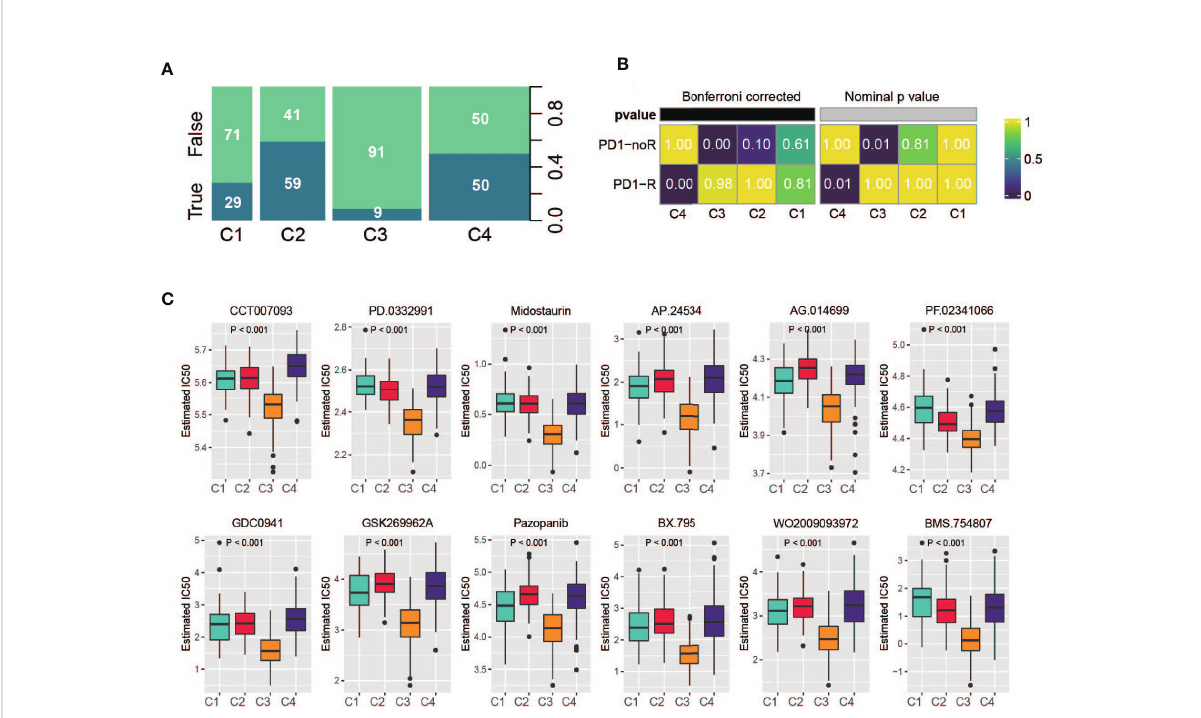
FIGURE 8 Drug sensitivity analysis. (A) Summarized result of TIDE analysis; the width of a cluster corresponds to the number of patients in that subtype; number represent the percentage of predicted responders/non-responders for each subtype. (B) SubMap analysis based on immunotherapy treated metastatic gastric cancer cohort, C4 shows high sensitivity. (C) Drug sensitivity based on Genomics of Drug Sensitivity in Cancer database, the top 12 drugs with the most signi fi cant p value were